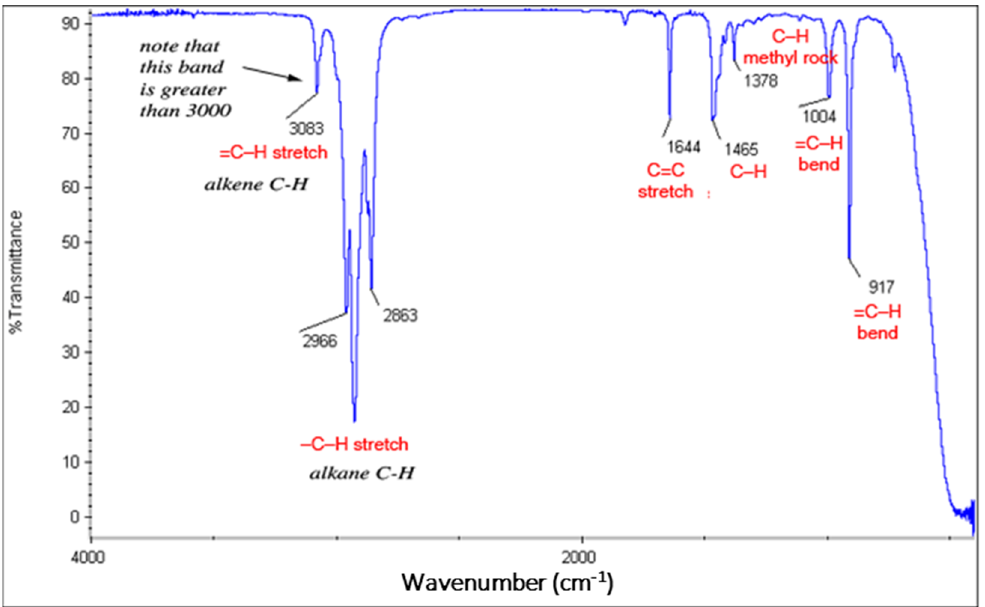
Figure 3. FTIR of Olefin. Figure 3. FTIR of